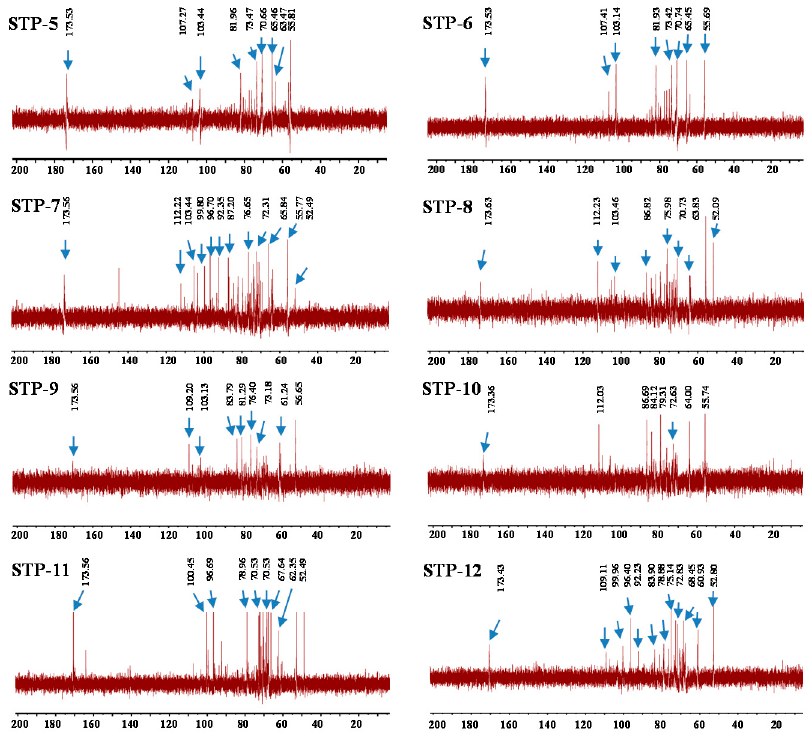
Figure 3. 13 C NMR spectra of TPs. TPs 1–12 represent tea polysaccharides as shown in Table 1.